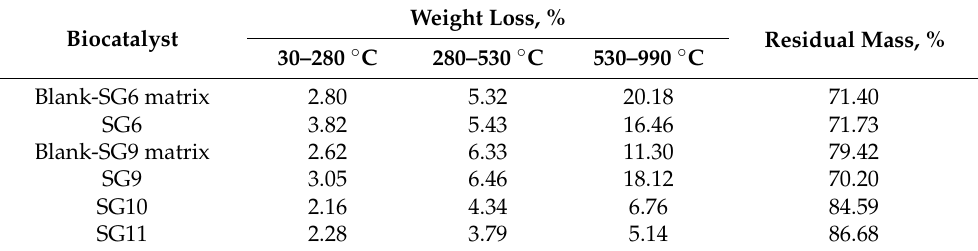
Table 4. Thermal behavior of biocatalysts that were obtained by the sol–gel entrapment of Cellic CTec2 cellulase.